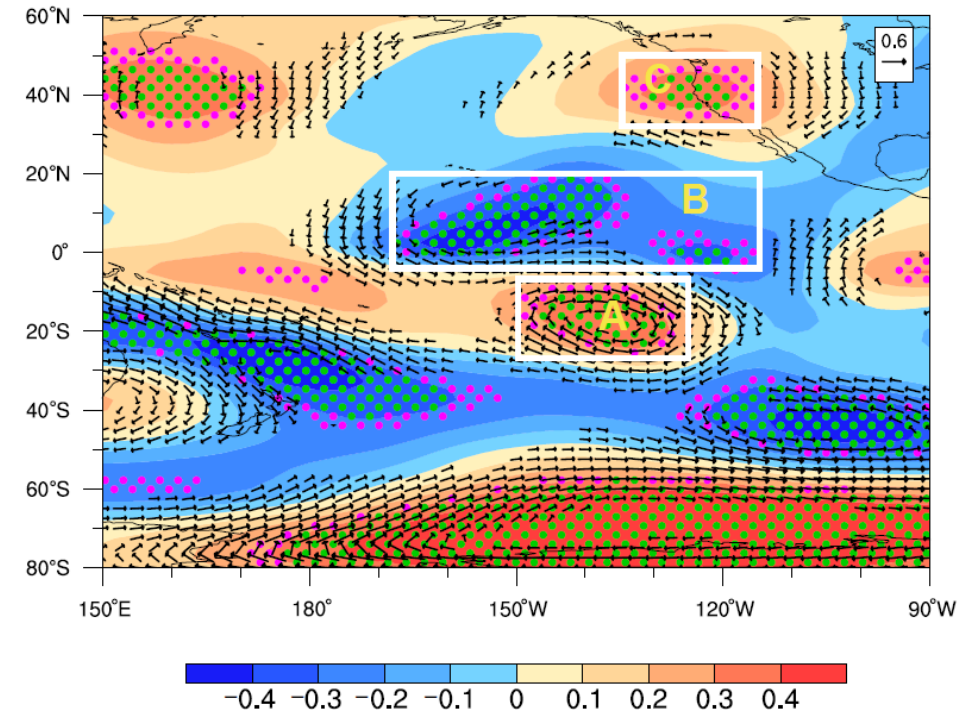
Figure 6. Partial correlation map between the winter SPODI and winter stream function (shading) and horizontal wind (vectors) at 300 hPa without the ENSO signal. The magenta and green stippled areas indicate statistical significance at the 90% and 95% confidence levels, respectively. The black vectors indicate that the statistical significance exceeds the 90% confidence level.